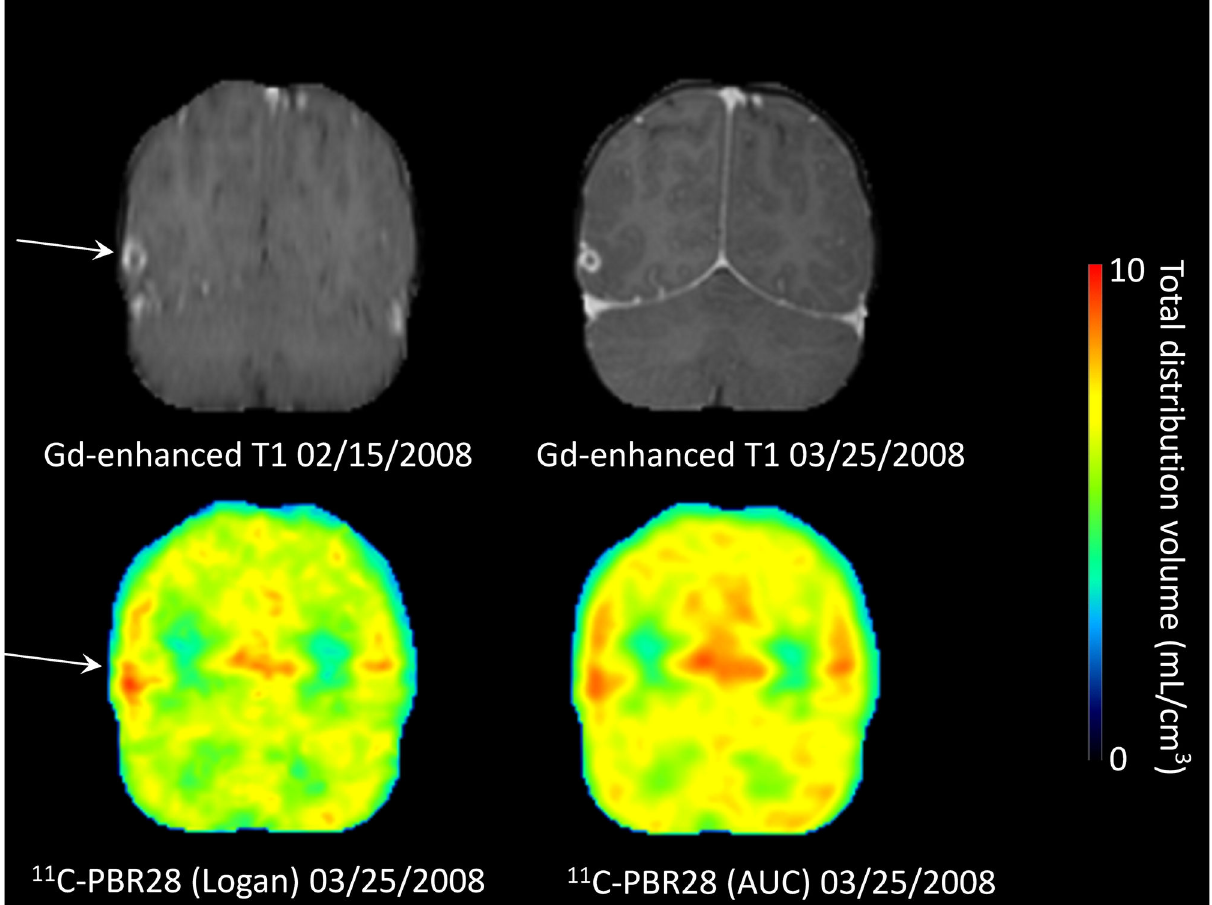
Figure 3. MR and PET images of patient 2 who showed a degenerating cyst (arrow). The patient presented with a seizure 85 days (01/06/2008) before the PET scan on 03/25/2008. On 02/15/2008 when the patient was asymptomatic, MRI scan showed a Gd-enhanced degenerating cyst in right temporal cortex (arrow). On the day of the PET scan (03/25/2008), the Gd-enhanced lesion slightly shrunk, and the PET scan showed increased 11 C-PBR28 binding based on Logan plot (21%) and area under the curve (AUC, 17%). The color bar applies to only the PET image on the left side.